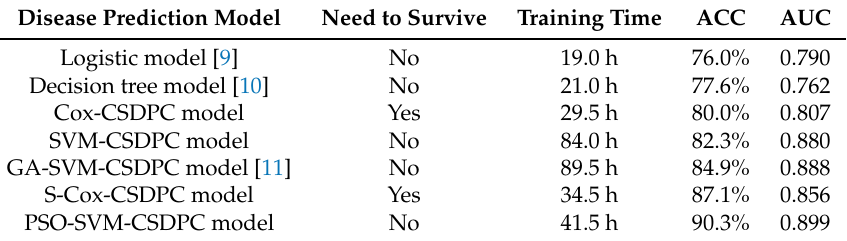
Figure 10. GA-SVM-CSDPC disease prediction model ROC curve. Table 1. Disease prediction model experimental results comparison